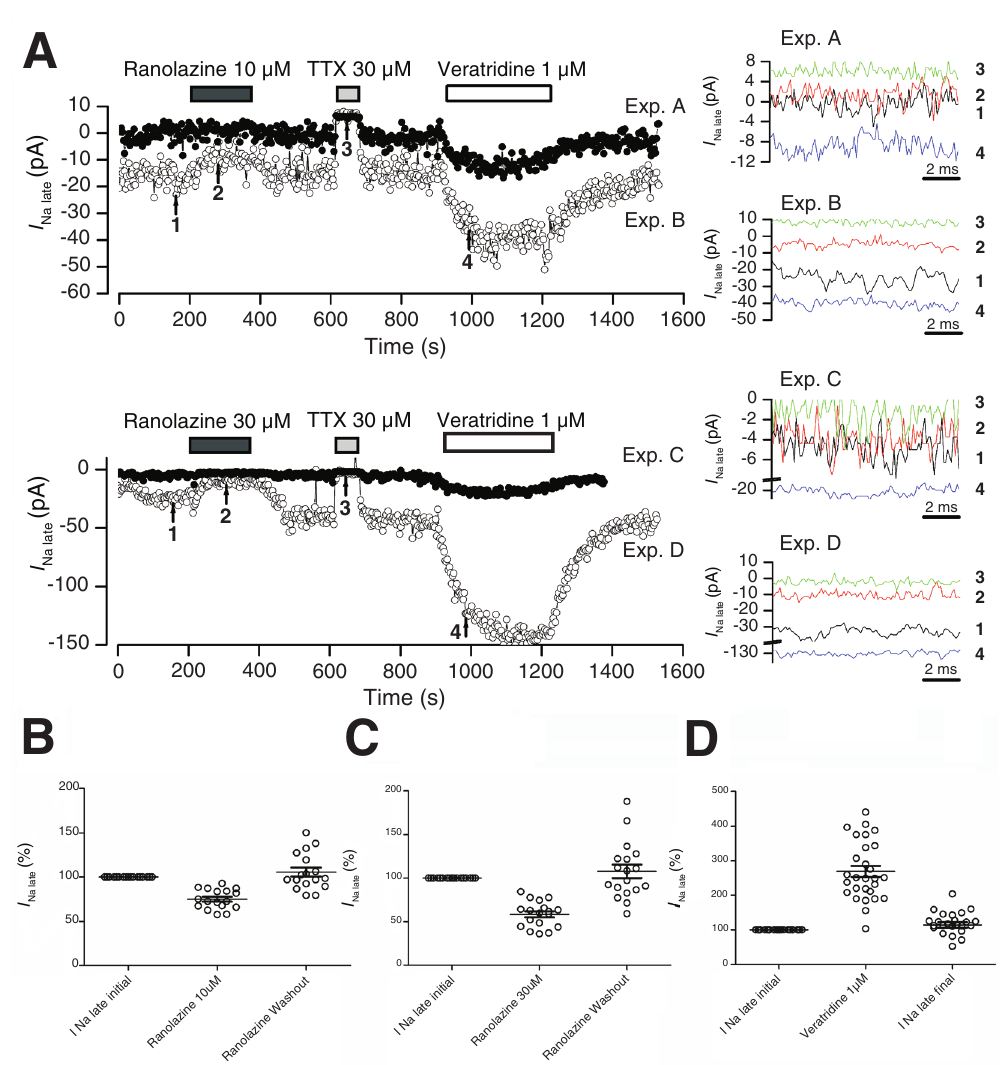
Figure 2. Effects of ranolazine, TTX and veratridine on the late Na + current in Nav1.5-expressing cells. A . Time plots of I typical experiments. Intervals of application of ranolazine 10 or 30 μM, TTX 30 μM, and veratridine 1 μM are indicated. Right panels: I traces from 260 to 270 ms at the time points marked with arrows and numbered in the left panels. B and C . Effects of ranolazine 10 and 30 μM, respectively, on relative levels of TTX-sensitive late Na + current. D . Effect of veratridine 1 μM. Mean values are indicated for each condition, and error bars represent